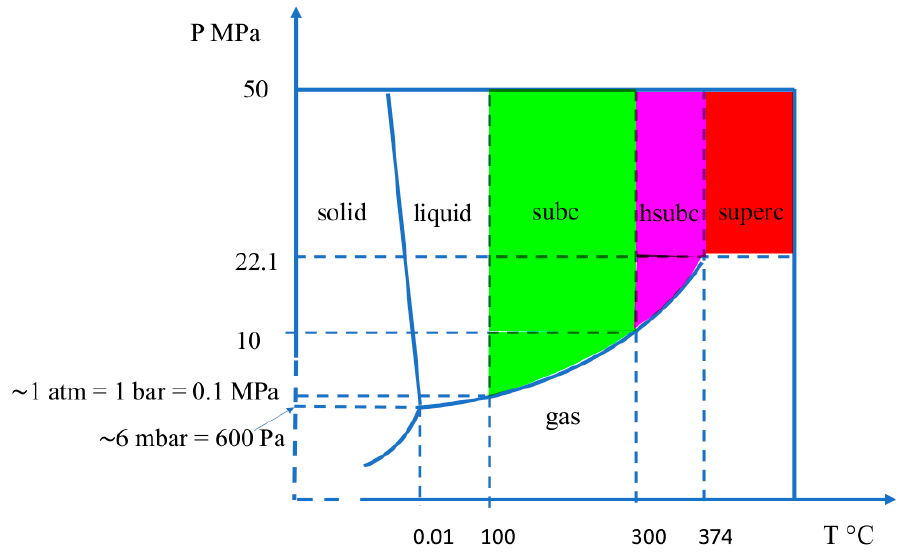
Figure 3. Approximate diagram of pressure and temperature for water, highlighting subcritical water. subc = subcritical water; hsubc = high subcritical water; superc = supercritical water. Concomitant to the oxidation of iron in high subcritical water, molecular hydrogen is released.